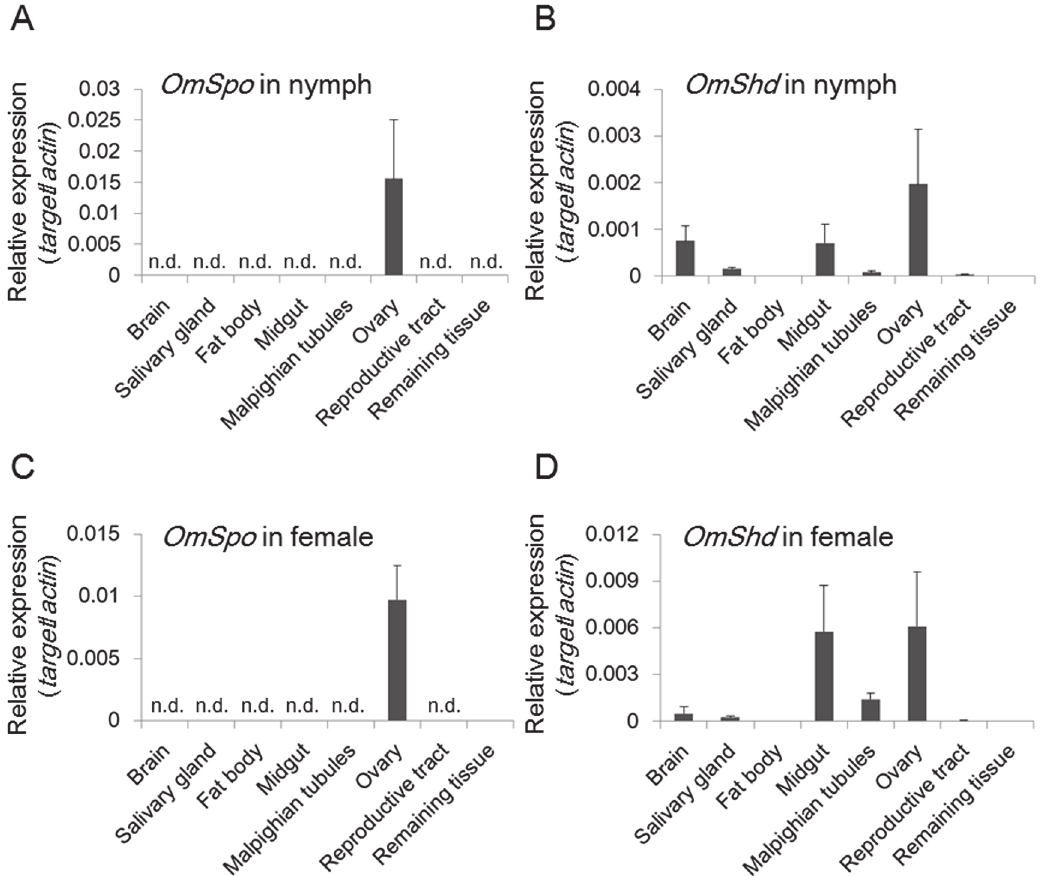
Fig 5. Expression sites of OmSpo and OmShd in nymphs and adult females of O . moubata . OmSpo (A) and OmShd (B) expression in final instar nymphs determined 9 days after engorgement by qRT-PCR (n = 3 – 4, mean ± se). OmSpo (C) and OmShd (D) expression in mated females determined 2 days after engorgement (n = 3 – 4, mean ± se). n. d. indicates no